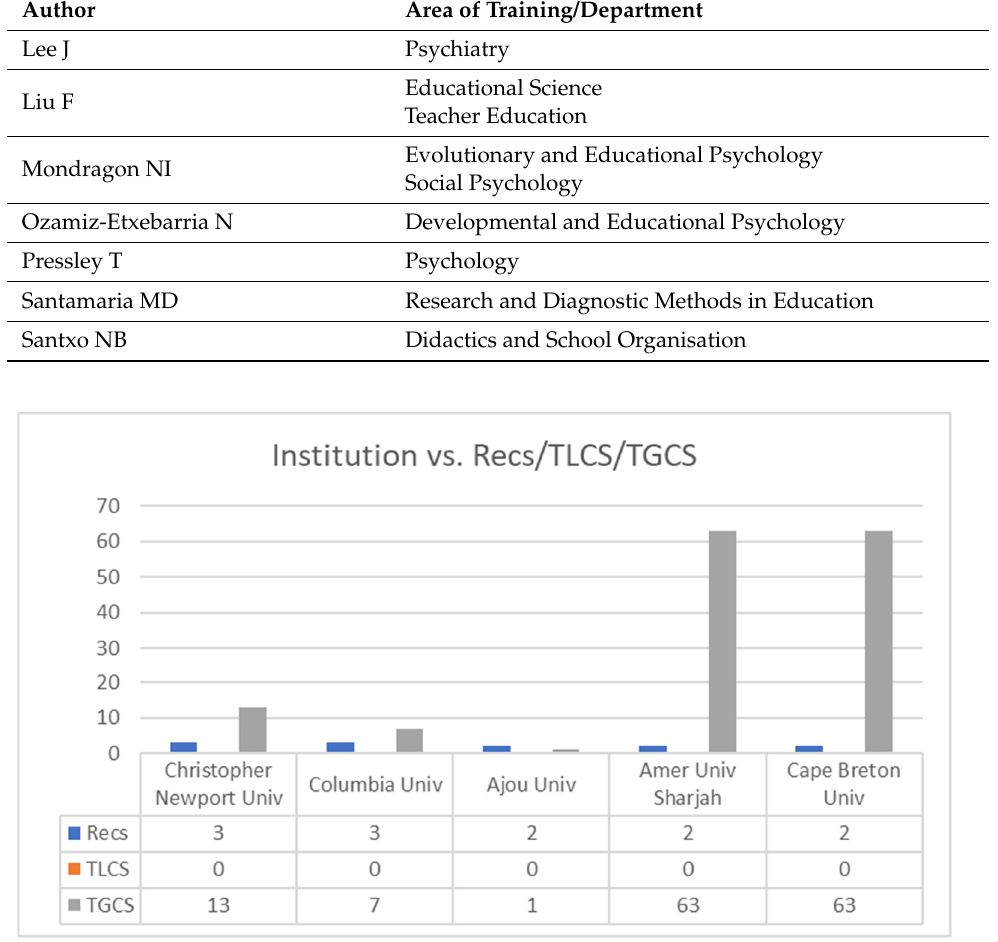
Figure 4. Comparison of countries with the most publications ( ≥ 5 Recs). Note: Recs is the number of articles, TLCS is the local citation score and TGCS is the global citation score. The map below shows the same distribution by country, showing all the countries that published at least 1 article (Figure 5).